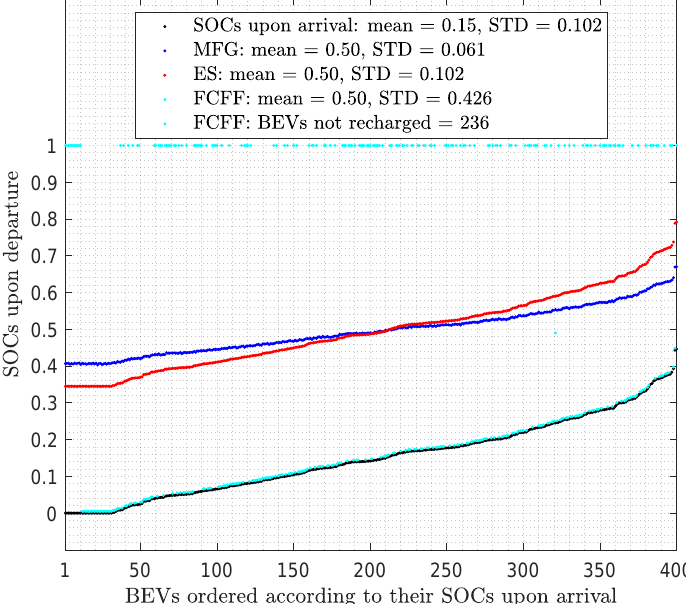
Figure 9. SOC levels at time of departure for a fixed population of 400 BEVs in the cloudy